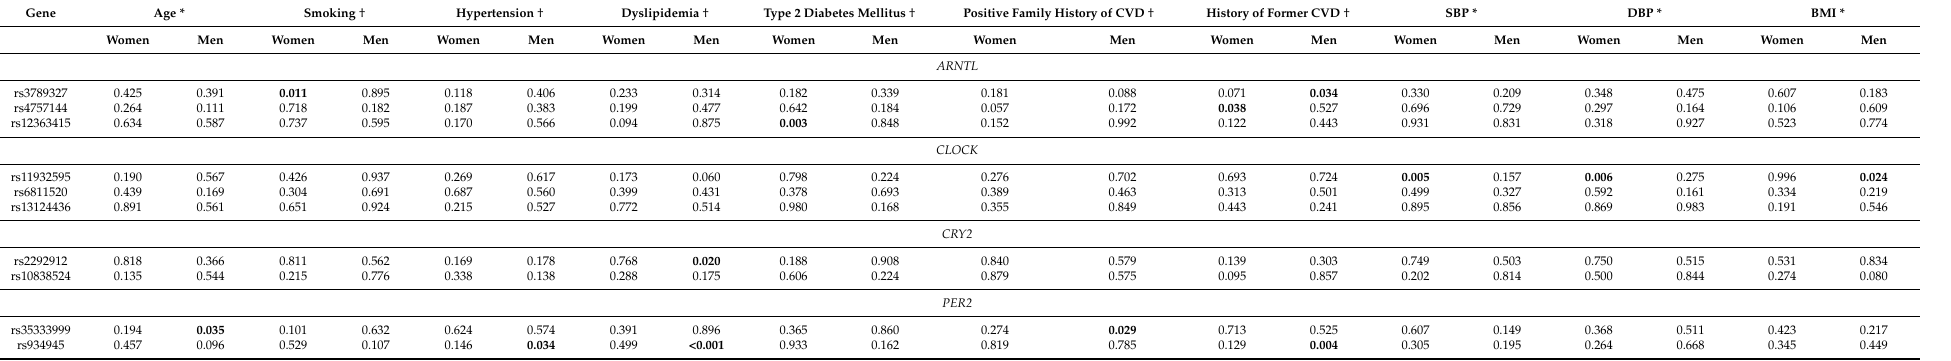
Table 5. The association between cardiovascular risk factors and circadian clock gene